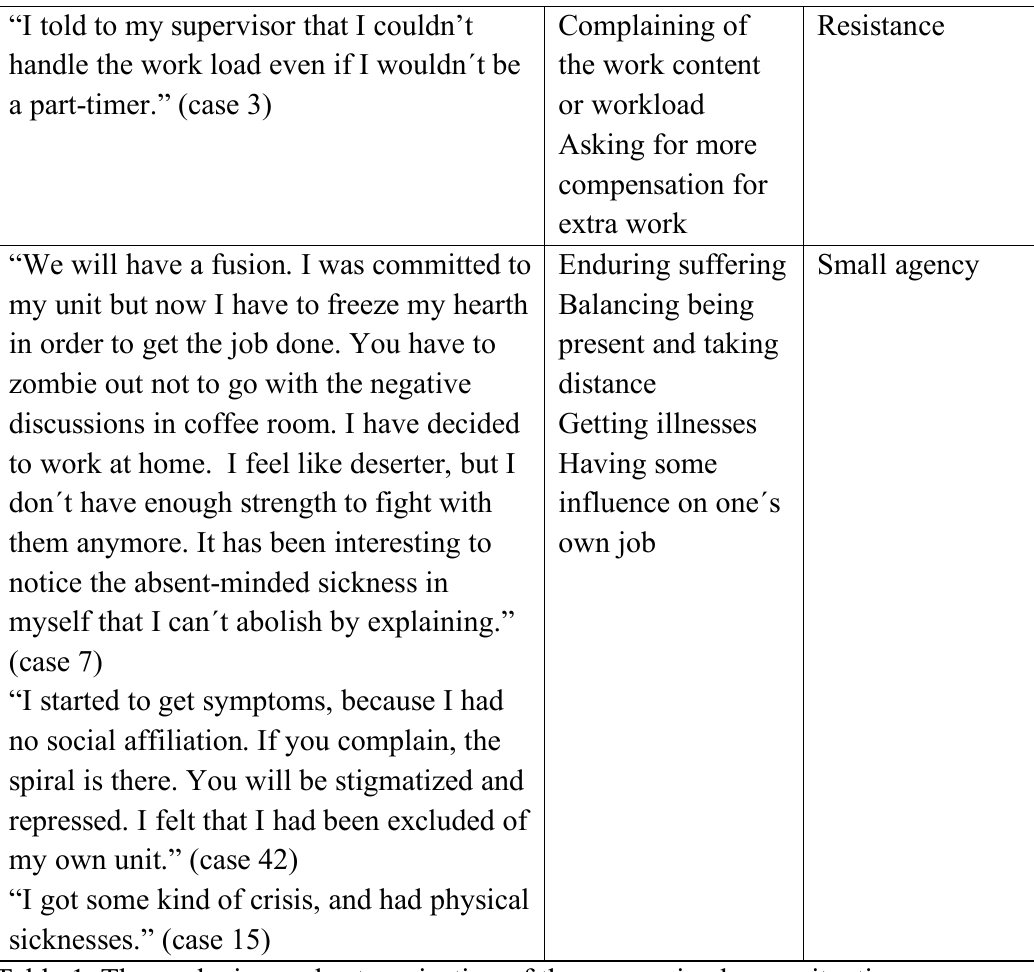
Table 1. The analyzing and categorization of the agency in change